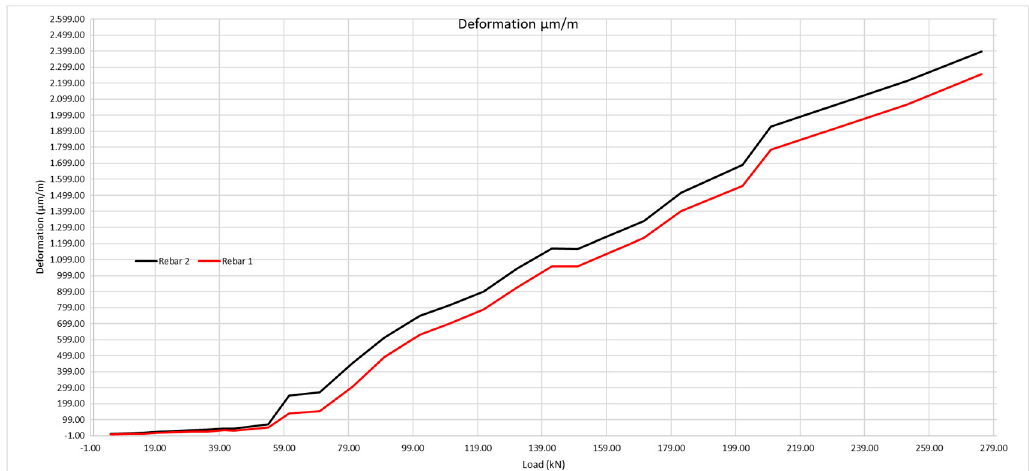
Figure 22. Deformation of the rebars 1 and 2 according to the loads applied.